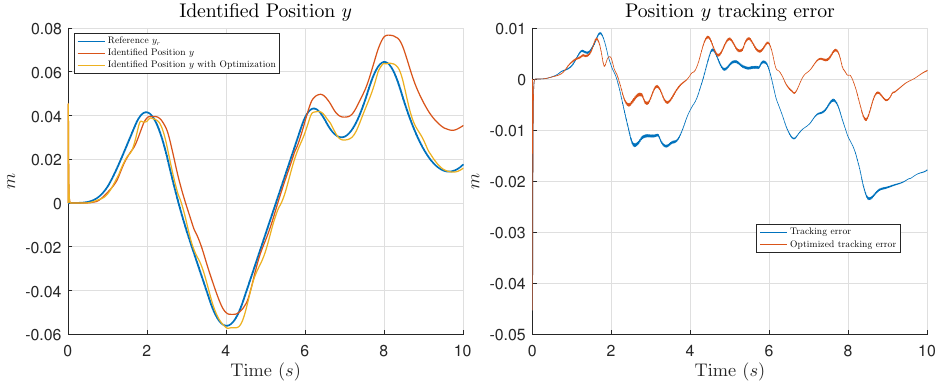
Figure 10. Tracking of y position ( left ) and error comparison ( right ) for the experimental test 1.